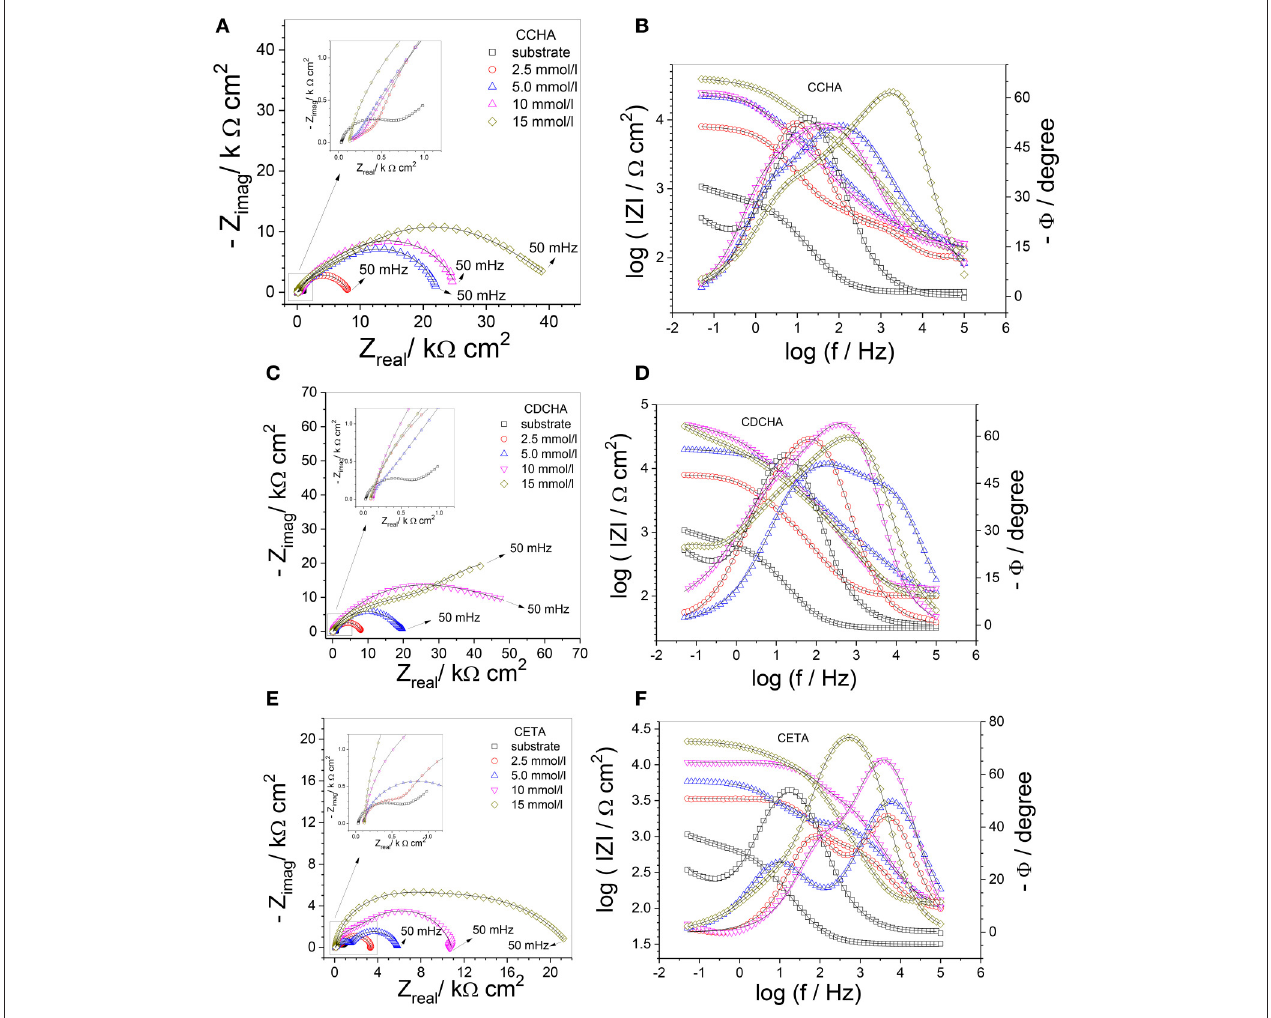
FIGURE 9 | Complex plane diagrams (A,C,E) and Bode plots (B,D,F) of zinc in 0.1mol L − 1 NaCl in the absence and presence of different caprylate salts concentrations. Experimental data (symbol) and fitting (solid line). Inserts put in evidence the high frequency region and mainly the impedance response of the